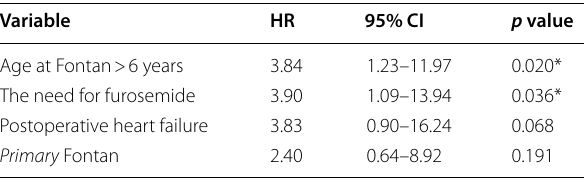
Table 3 Multivariate analysis of factors affecting 12-year survival after Fontan